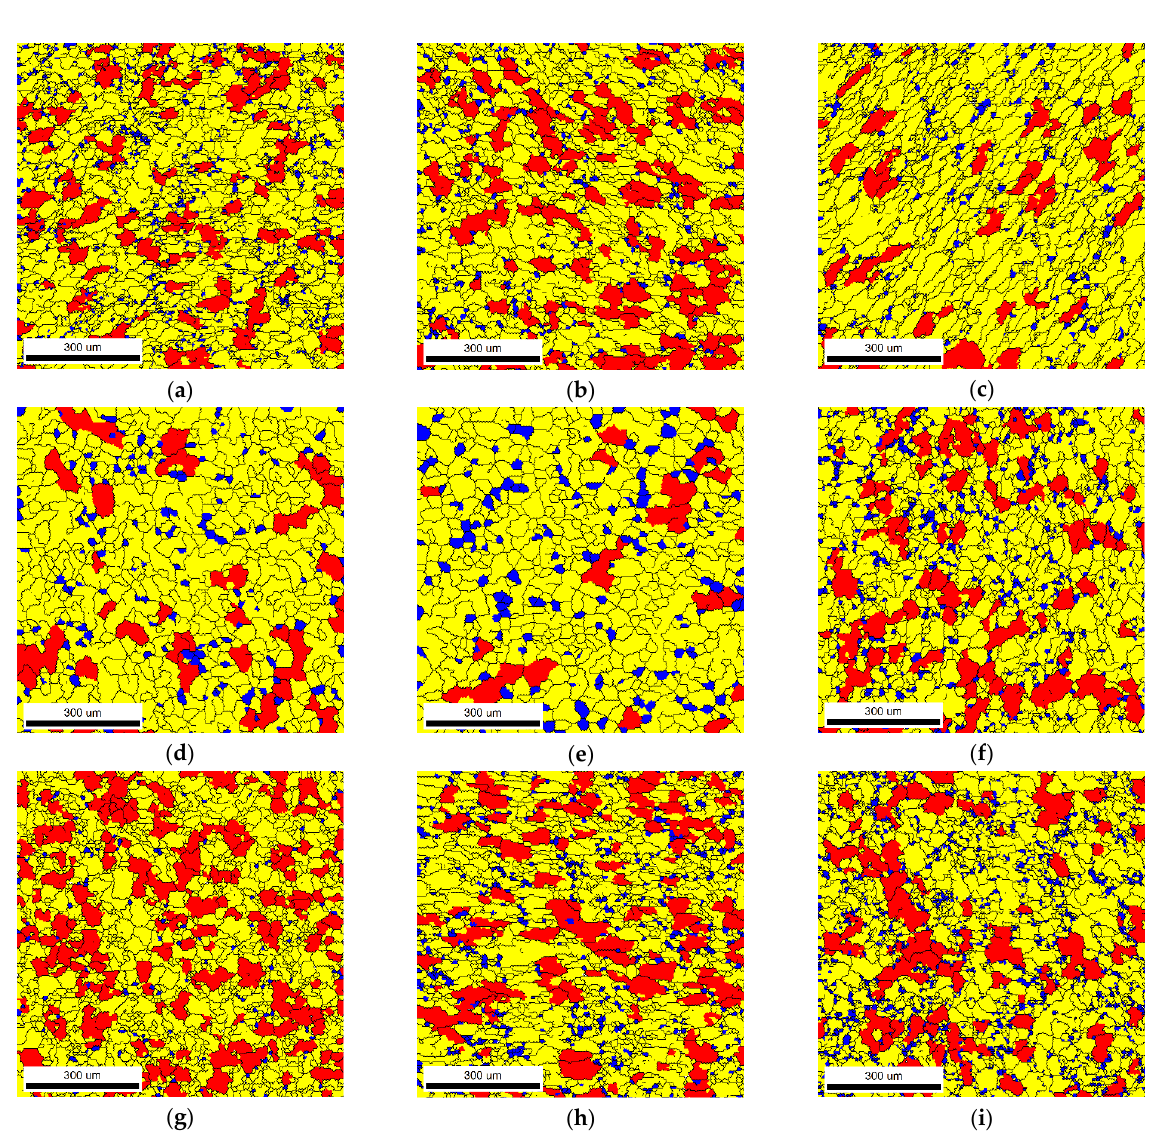
Figure 9. The GOS diagrams obtained from the thermal compression deformation experiment. (The subgraph captions ( a – i ) correspond to the experimental groups (1) to (9) in Table 2,